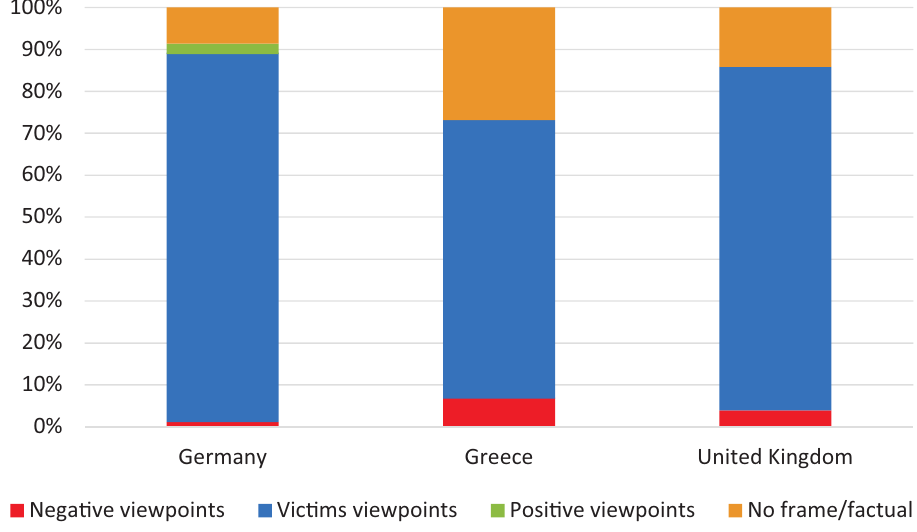
Figure 3. Distribution of viewpoints on